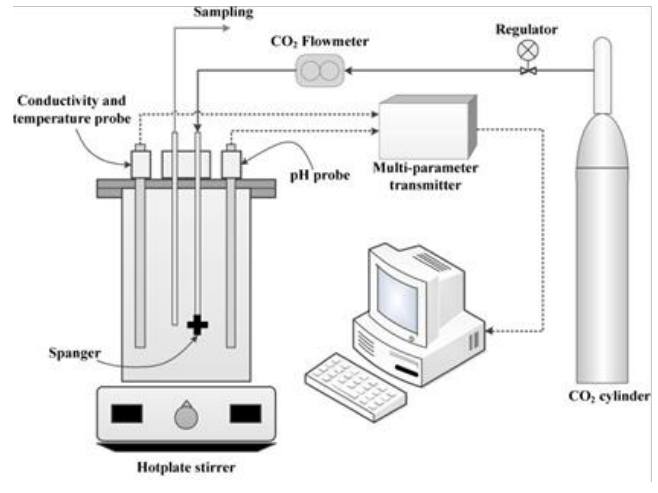
Figure 6. Schematic diagram of accelerated carbonation device [99].